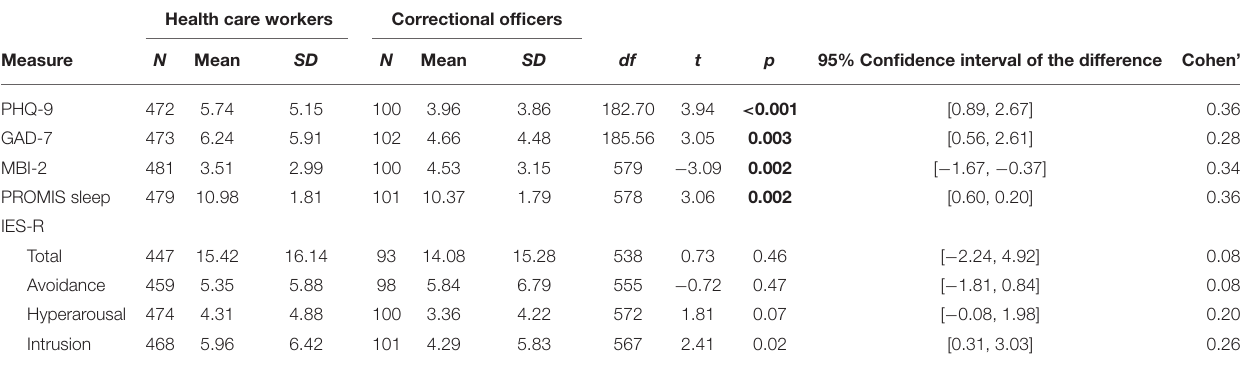
TABLE 3 | Differences in mental health measures between health care workers and correctional officers. Health care workers Correctional